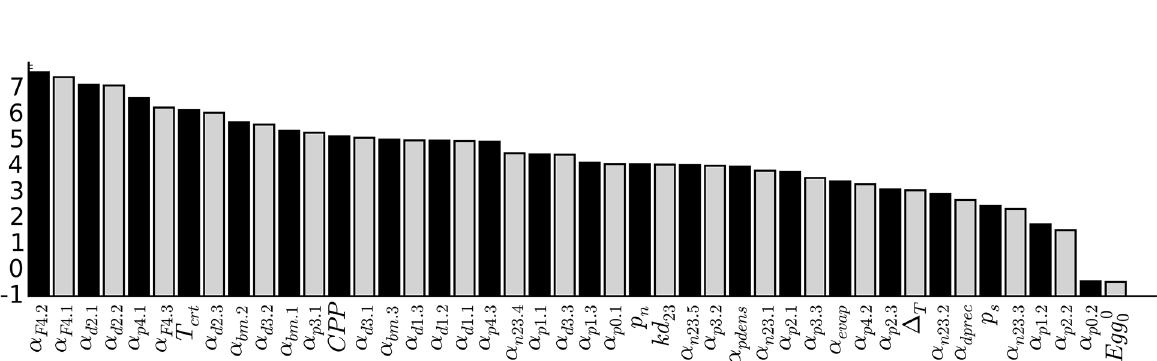
Fig 4. Sensitivity analysis for Θ 1. The bar chart displays the logarithm of sensitivity, H y , along the set of parameter dimensions included in the